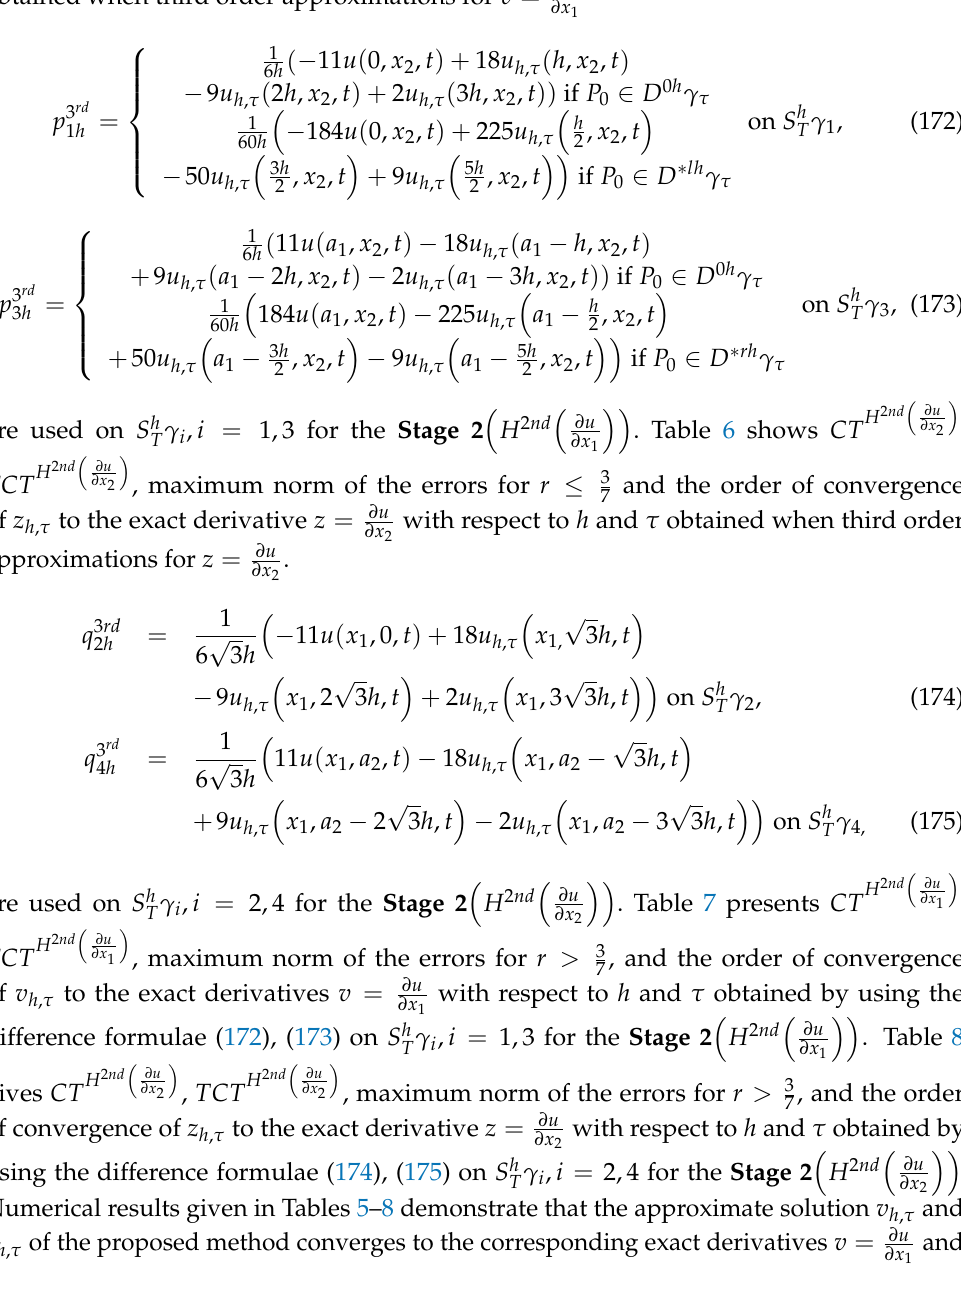
and the approximate solution z 2 − 6 ,2 − 15 at t = ∂ x 2